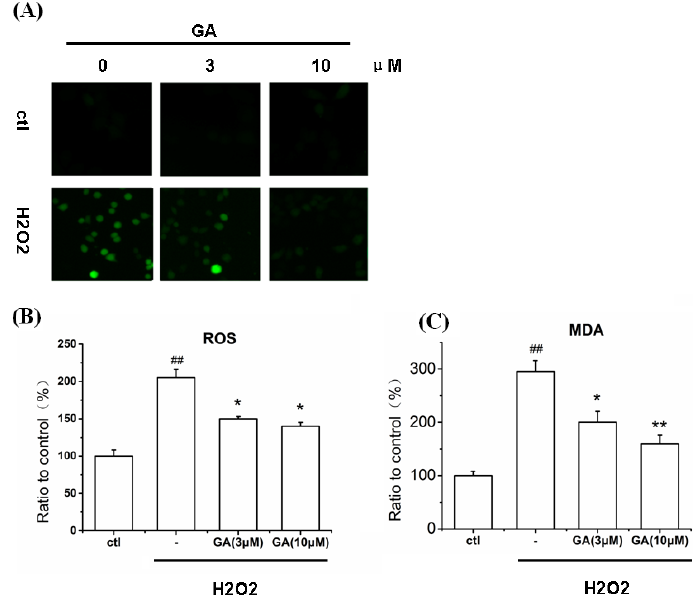
Figure 7. Attenuation of H 2 O 2 -induced ROS and MDA production by GA. Cells pretreated with/without GA (3 and 10 μM, respectively) for 30 min, were exposed to H 2 O 2 (100 μM) for 12 h. The production of ROS and MDA were then determined. ( A ) The fluorescence intensity of DCFH-DA, which were photographed using high content screening system; ( B ) Histogram showing the ROS levels in RGC-5 cells after treatment with H 2 O 2 in the presence or absence of GA; ( C ) Histogram showing the MDA levels in RGC-5 cells after treatment with H 2 O 2 in the presence or absence of GA. ## p < 0.01 vs. control group; * p < 0.05, ** p < 0.05 vs. H 2 O 2 -treated group ( n =